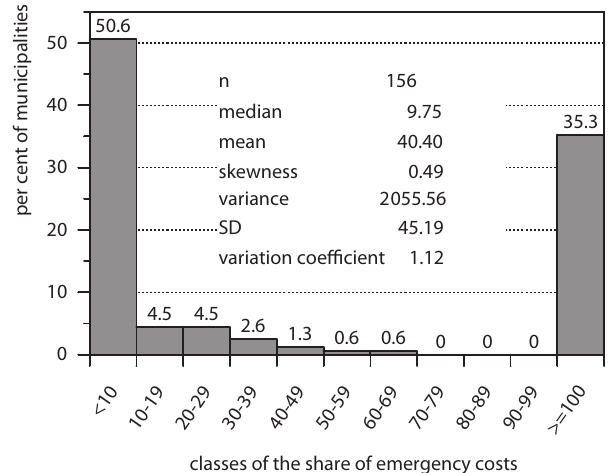
Fig. 7. Logarithmic scatterplot of the total direct losses and the costs of emergency per